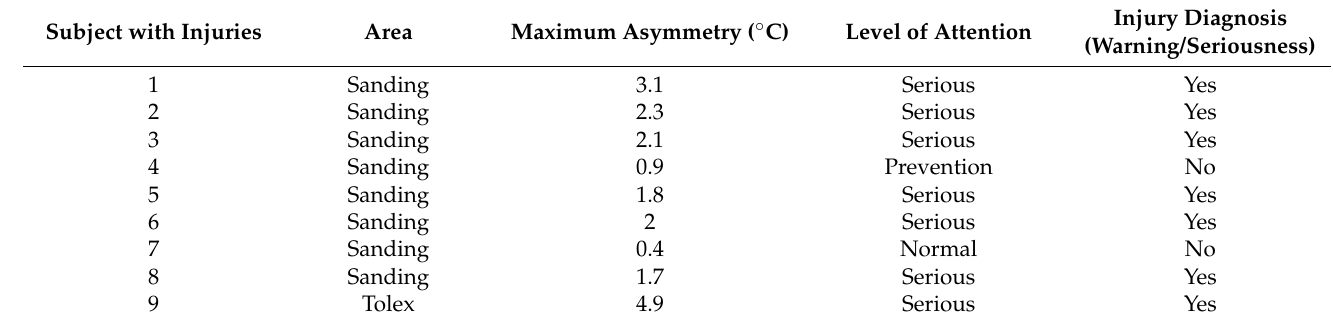
Table 5. Diagnostic results of asymmetric wrist injuries in the palmar region of the hand.